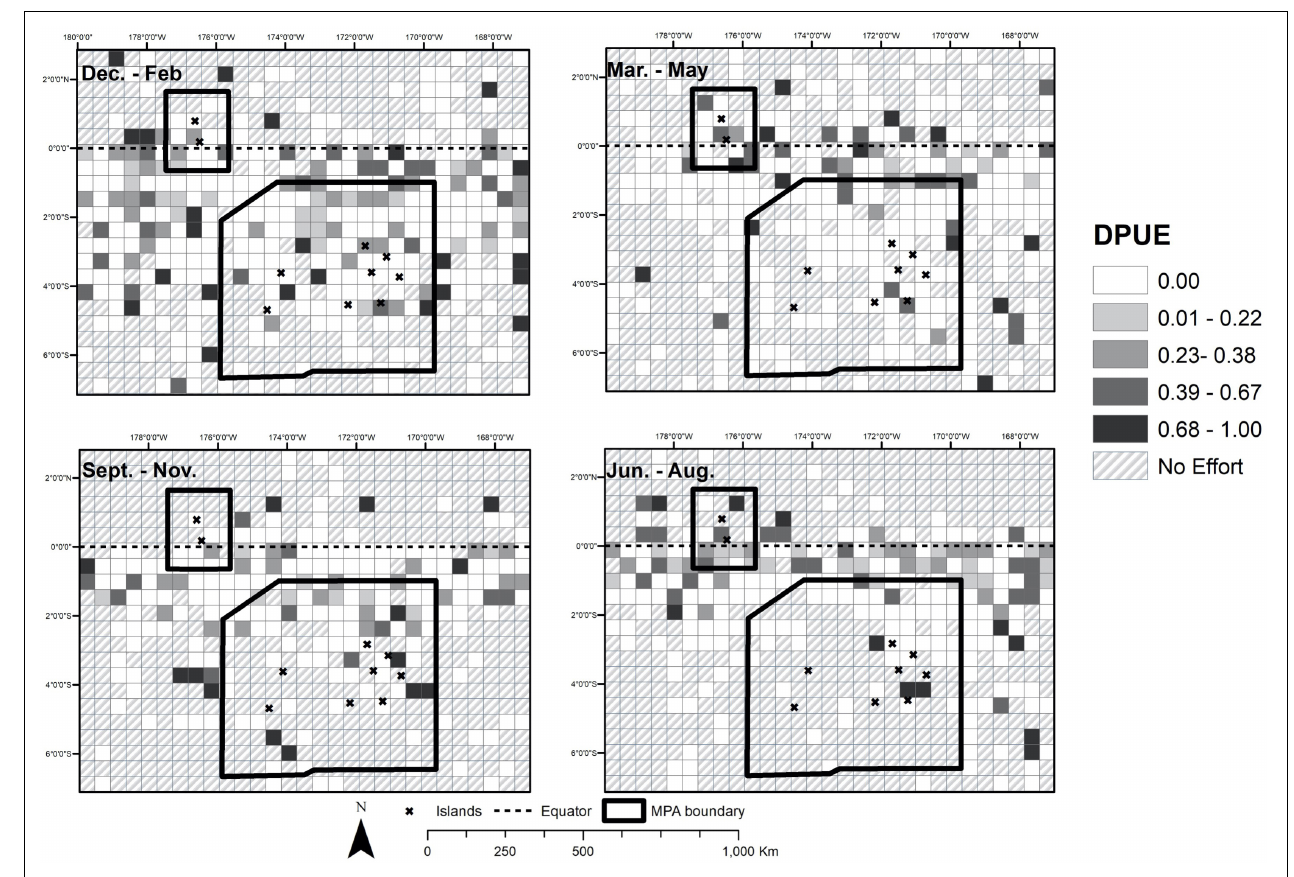
FIGURE 6 | Detections per unit effort of sperm whale sightings in quarterly